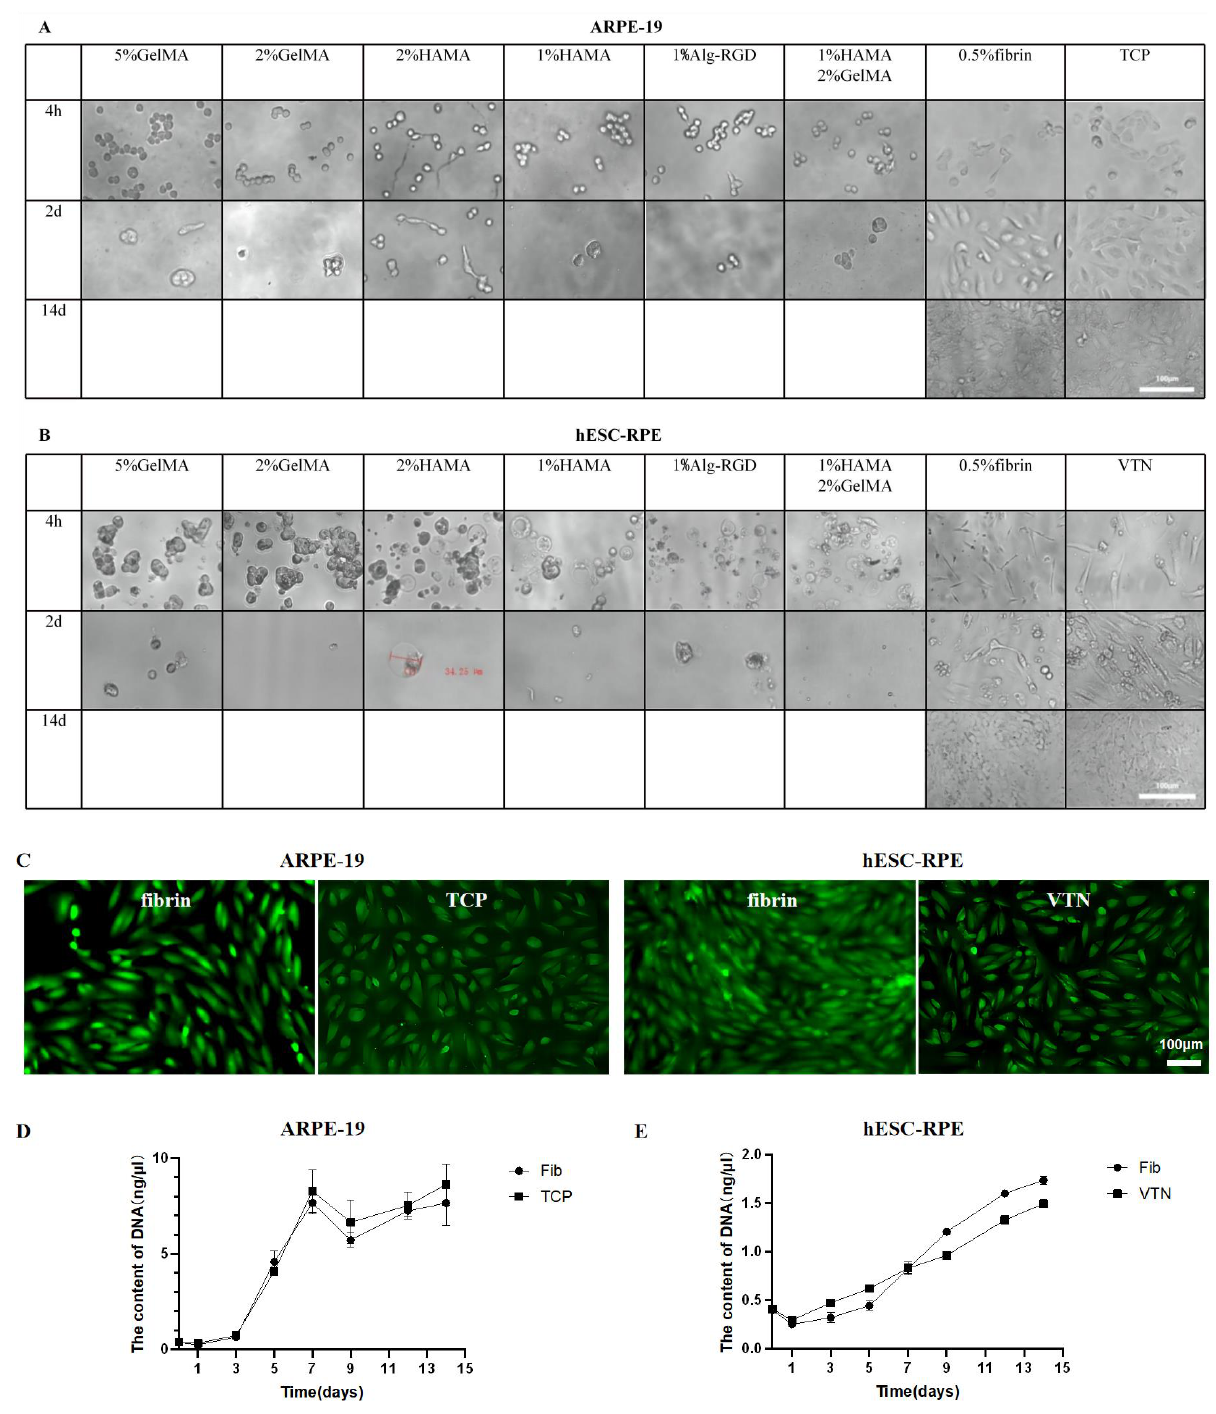
Figure 3. The seven groups of hydrogels with different concentrations prepared as the substrates for ARPE-19 as well as hESC-RPE cell growth. Only fibrin protein hydrogels allowed cells to form a uniform distribution at low concentrations, while other types of hydrogels formed cell aggregates without adhesion and were easily washed off after two days. ( A ) Optical images of ARPE-19 on different hydrogels. ( B ) Optical images of hESC-RPEs on different hydrogels, while damaged cells with special vesicles were measured by the red bar. ( C ) Representative confocal microscopy images of RPE on fibronectin, which was stained with calcein and ethylene dimer for live/dead assay. ( D ) The DNA content of ARPE-19 on fibrin as well as the TCP control. ( E ) The DNA content of hESC-RPEs on fibrin as well as the VTN control.